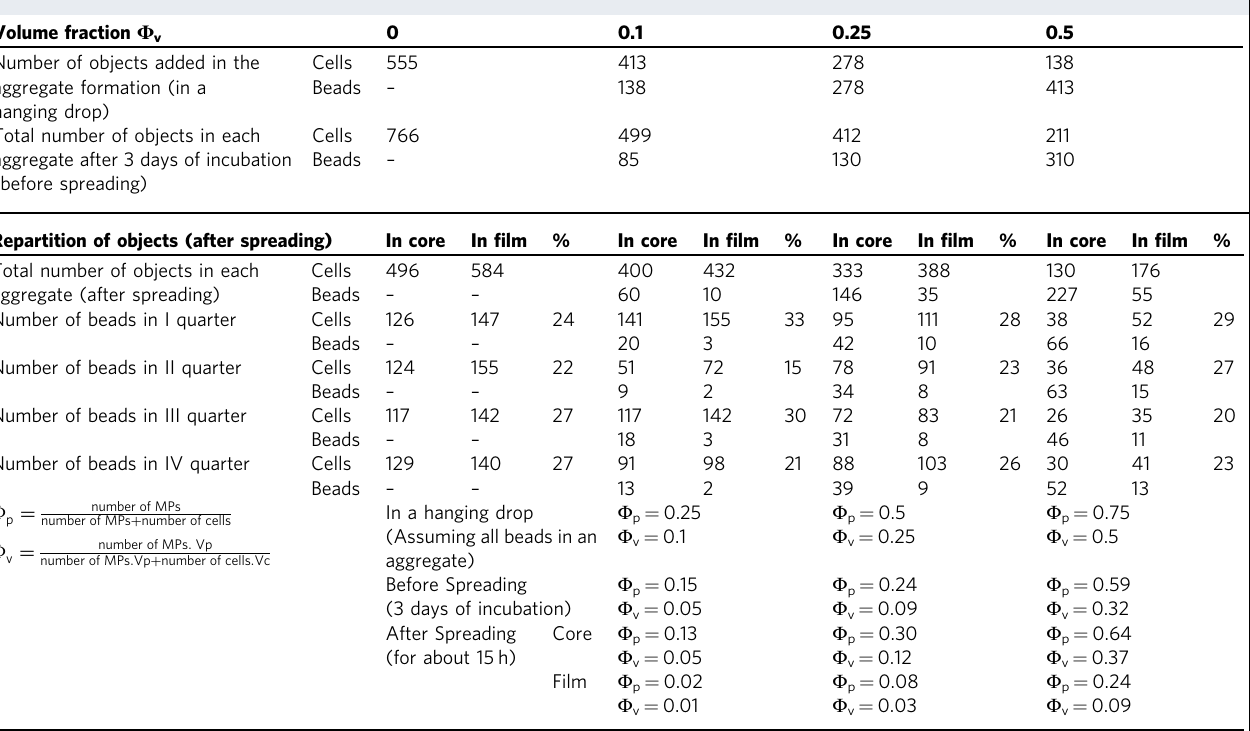
n = 5 aggregates with Ps-10 microparticles (MPs) are measured as hanging droplets, before, and after spreading. Aggregates are assumed to be spherical and divided in four Quarters for the